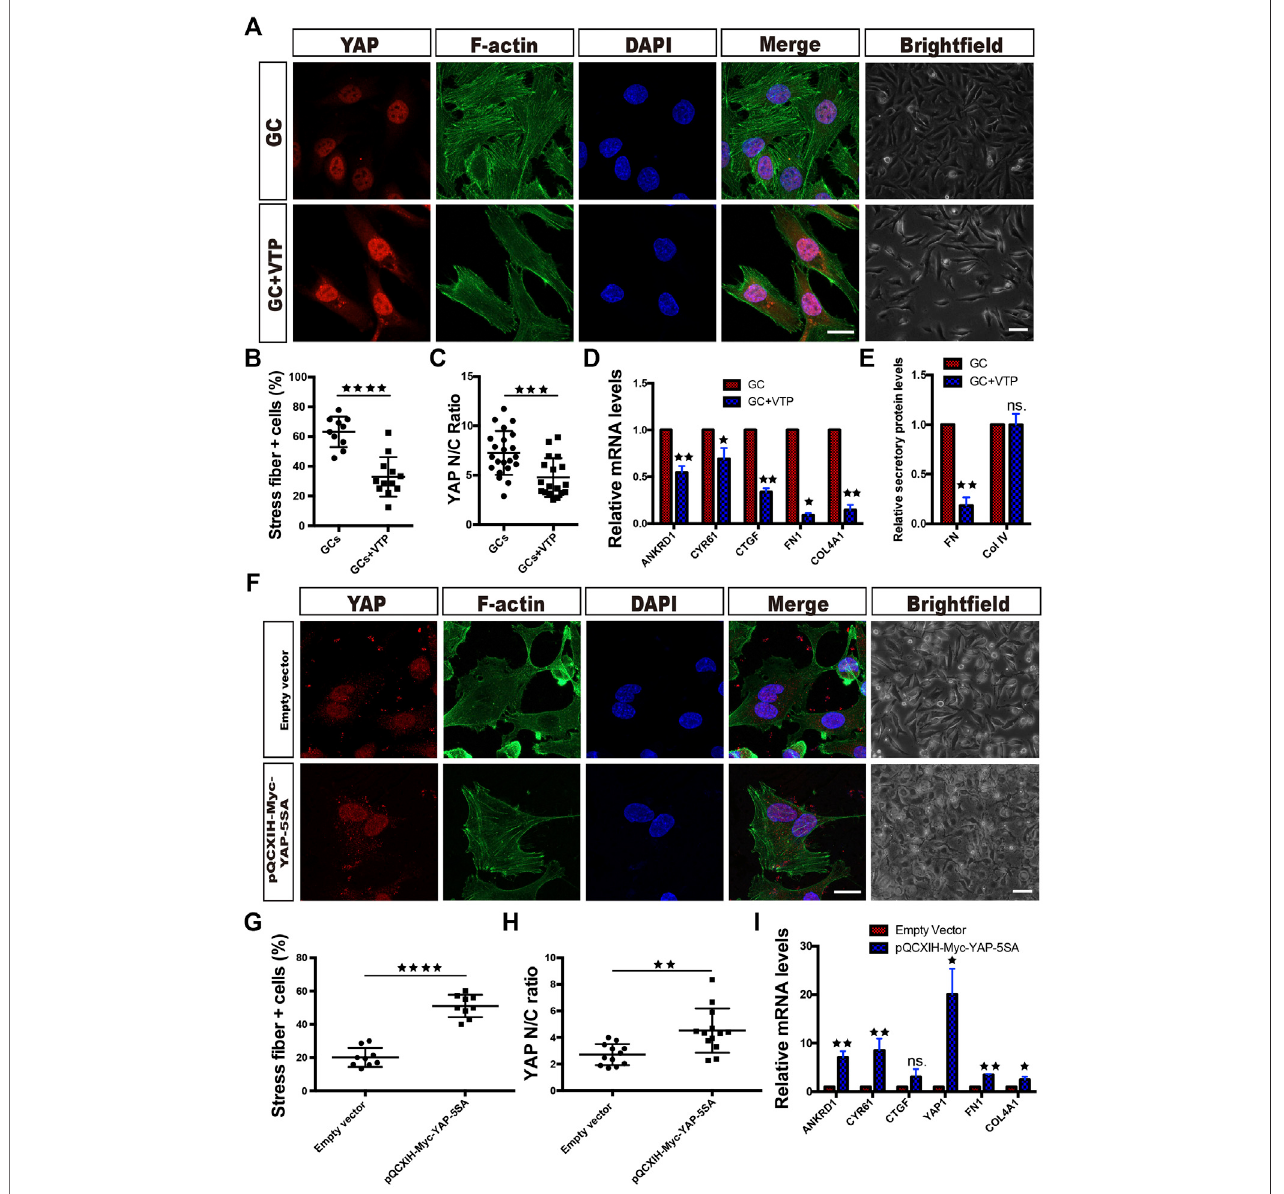
FIGURE 3 | YAP activity controls ECM component expression and morphological changes in HRCECs. (A) : YAP/F-actin/DAPI immuno fl uorescence staining of HRCECs treated with 0.8 μ M hydrocortisone alone (GC) or in combination with 10 μ M VTP (GC + VTP) for 72 h. Scale bars, 20 μ m. Bright fi eld microscopy images of HRCECs treated in the indicated condition. Scale bars, 100 μ m. (B) : Quanti fi cation of the percentage of cells displaying actin stress fi bers for the two treatment conditions in (A) . (C) : Quanti fi cation ofthe ratioofthe average immuno fl uorescence intensityofYAPbetweenthe nucleus and thecytoplasm ofthecells in (A) . (D) : Real-time qPCR analysis of HRCECs treated as in (A) . The mRNA levels of FN1/COL4A1 (ECM component) and ANKRD1/CYR61/CTGF (targets of YAP) were calculated. The Real-time qPCR analysis of ANKRD1/CYR61/CTGF was biologically repeated fi ve times, and the analysis of FN1/COL4A1 was biologically repeated threetimes. (E) :FNandColIVsecretioninsupernatantofHRCECstreatedasin (A) asanalyzedviaELISAfollowedbynormalizationtoGCgroup. (F) :YAP/F-actin/DAPI immuno fl uorescencestainingofHRCECstransducedwiththeYAP-5SAplasmidornot.Scalebars,20 μ m.Bright fi eldmicroscopyimagesofHRCECstreatedunderthe indicated condition. Scale bars, 100 μ m. (G) : Quanti fi cation of the percentage of cells displaying actin stress fi bers for the two treatment conditions in (F) . (H) : Quanti fi cation of the ratio of the average immuno fl uorescence intensity of YAP between the nucleus and the cytoplasm of the cells in (F) . (I) : Real-time qPCR analysis of HRCECs treated as in (F) . The mRNA levels of FN1/COL4A1 (ECM component), YAP1 and ANKRD1/CYR61/CTGF (targets of YAP) were calculated. The error bars representthemean ± SD,andallexperimentswerebiologicallyrepeatedthreetimes,excepttheexperimentin (D) .* p < 0.05;** p < 0.01;*** p < 0.001,**** p < 0.0001;ns., not signi fi cant. Student ’ s two-tailed paired t-test (D,E,I) or Student ’ s two-tailed unpaired t-test (B,C,G,H) . ECM extracellular matrix, VTP vertepor fi n.